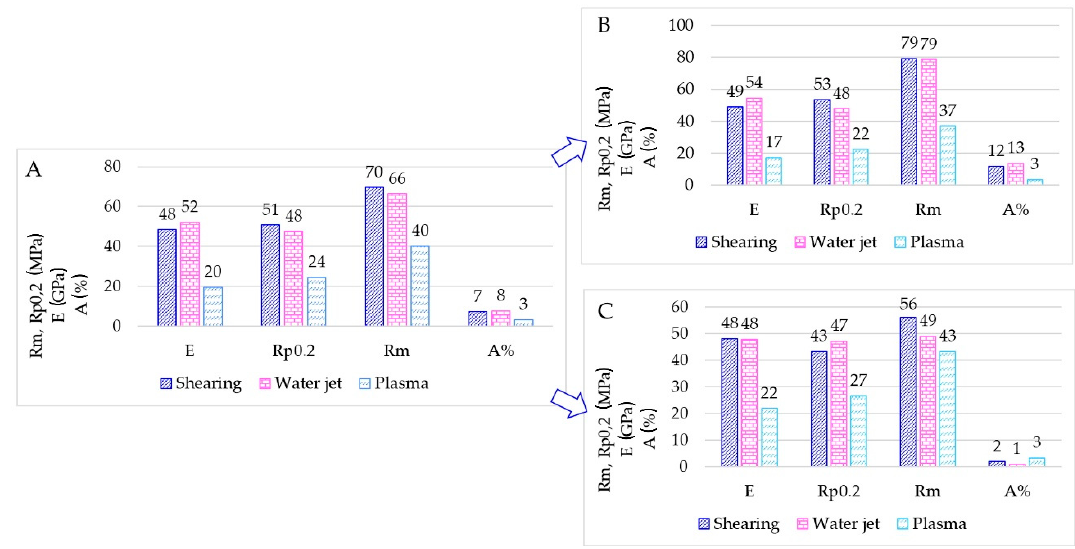
Figure 11. ( A ) Overall bar chart for TIG-welded sheets. ( B ) Bar charts for as-welded samples. ( C ) Bar charts for milled samples.